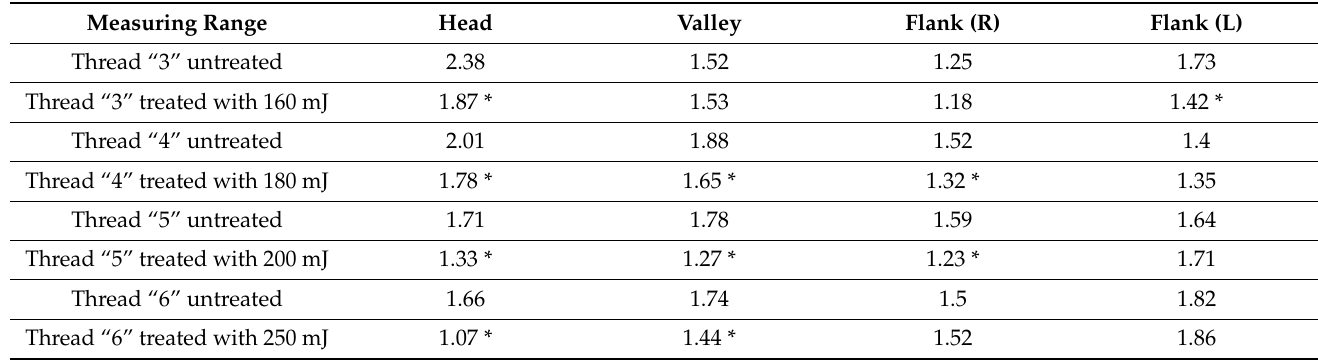
Table 1. Illustration of the treated and untreated implant surfaces of the SLA ® . Shown are the implant thread areas “3” to “6” where a change in roughness (*) was measured due to treatment with an Er:YAG laser. The values were given in µ m. No changes could be observed in implant thread areas “1” and “2” at 120 and 140 mJ, respectively.